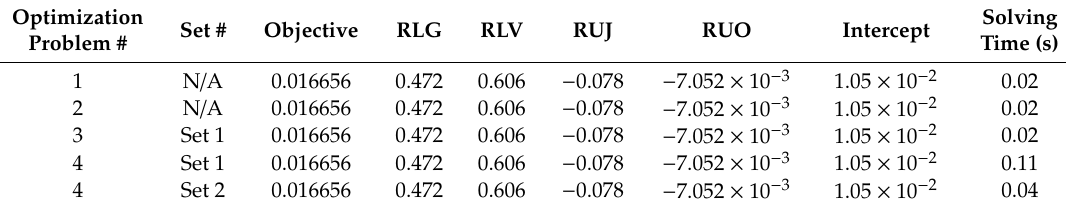
Table 2. Optimization outputs: estimating CVaR with the linear regression, α =